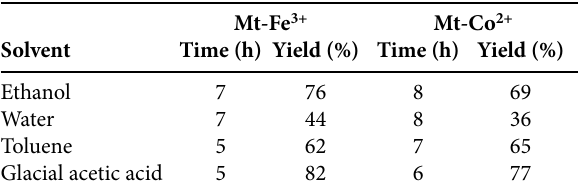
Table 5 . Effect of the solvent on the yield of the